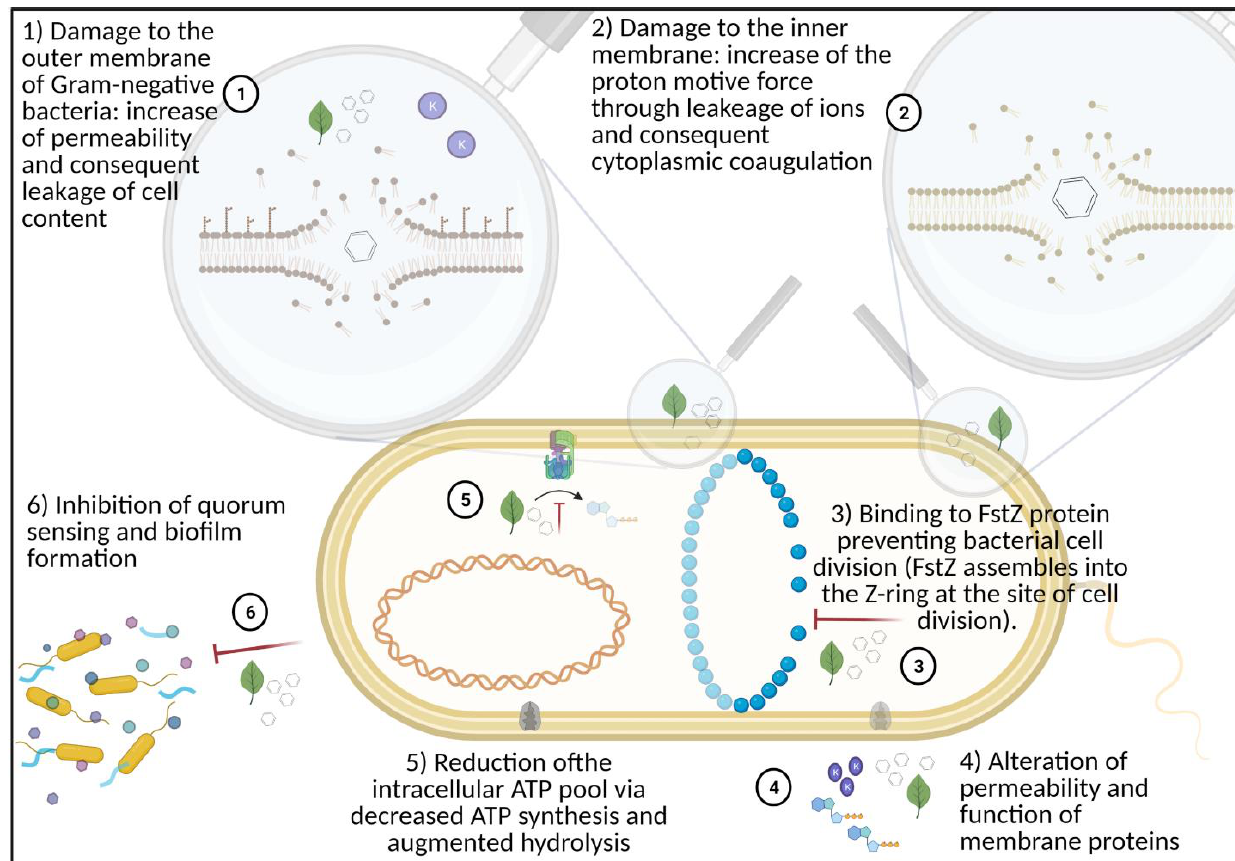
Figure 2. Antimicrobial mode of action of nature-identical compounds (NIC). Botanicals can have different targets to exert their antimicrobial mode of action ( 1 – 6 ). Created with Biorender.com (accessed on 19 April 2021).